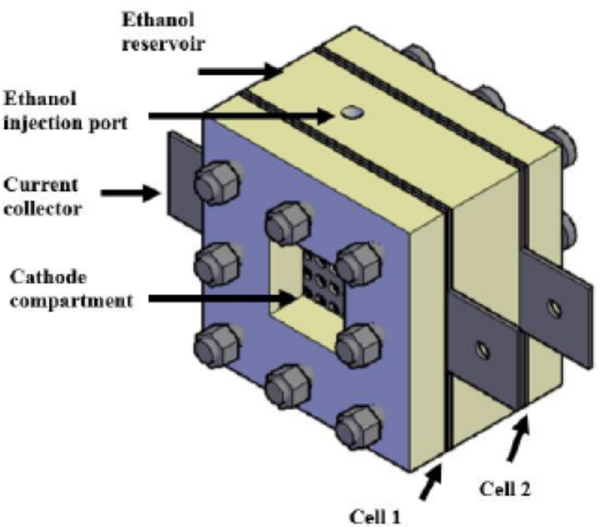
Figure 16. Schematic of assembled dual-cell PS-DEFC stack. Reproduced from [162] with permission from EDP Sciences 2020.